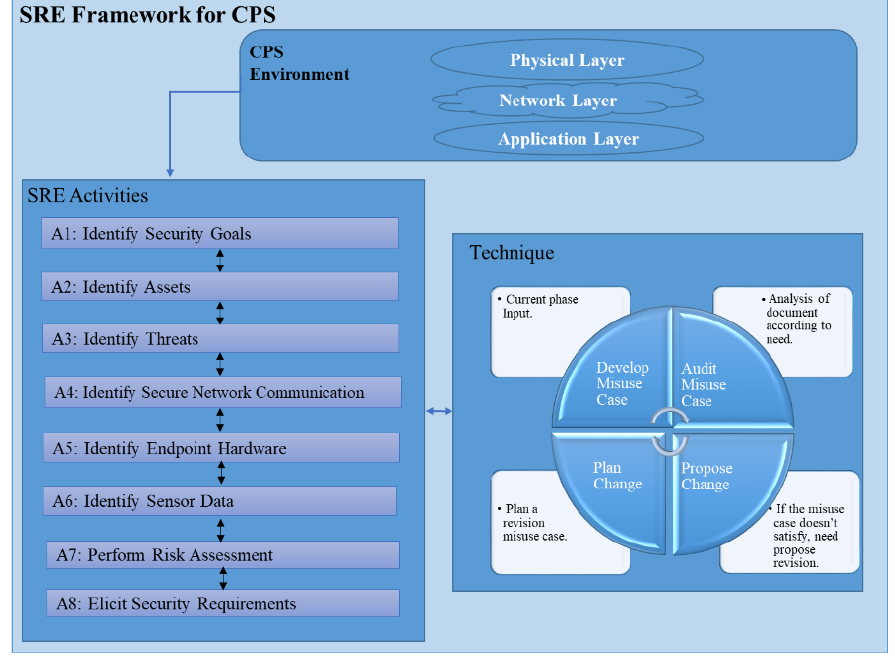
Figure 4. SRE Framework for CPS.